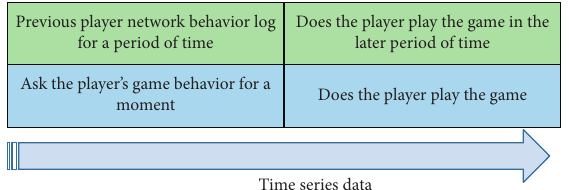
Figure 3: Time series data set